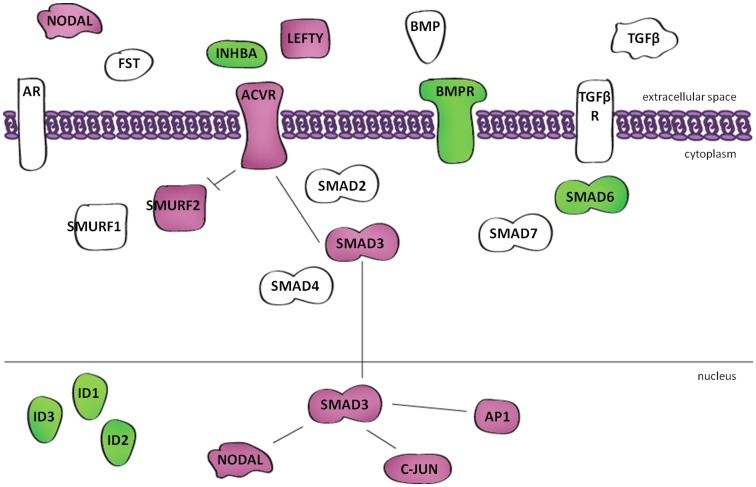
Mutant FOXL2 regulates the expression of genes in the TGF-β signalling pathway.Figure schematically highlights those genes in the TGF-β pathway that are regulated by mutant FOXL2. All genes in magenta show increase in expression, genes in green show decrease in expression.